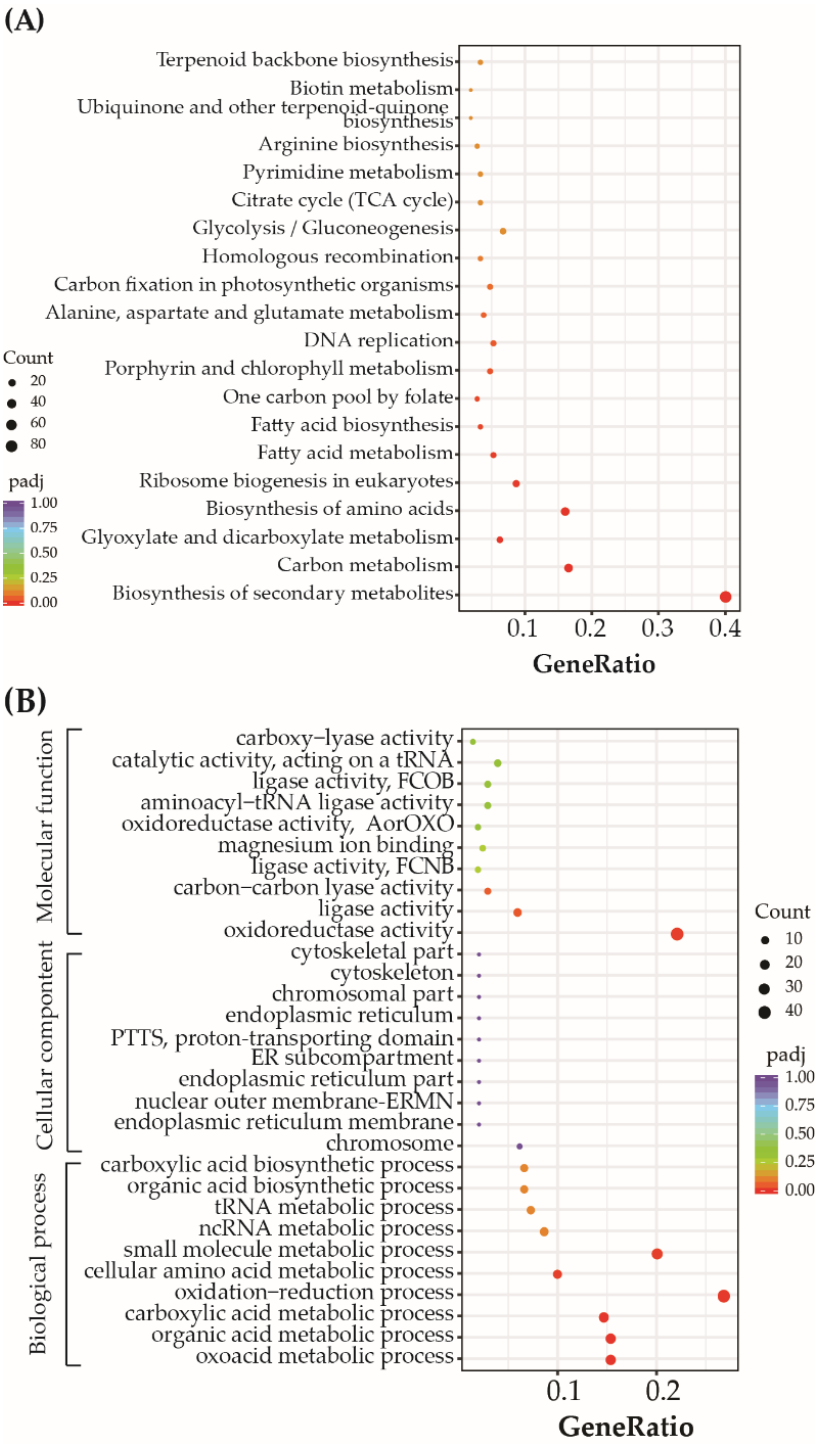
Figure 4. The 20 most abundant Kyoto Encyclopedia of Genes and Genomes pathways ( A ) and 10 most abundant Gene Ontology classifications ( B ) of differentially expressed genes after exposure to mixtures of BDE-47 and nickel treatments. Nuclear outer membrane-endoplasmic reticulum membrane network: ERMN; endoplasmic reticulum: ER; proton-transporting two-sector ATPase complex, proton-transporting domain: PTTS; ligase activity, forming carbon-nitrogen bonds: FCNB; ligase activity, forming carbon-oxygen bonds: FCOB; oxidoreductase activity, acting on the aldehyde or oxo group of donors: